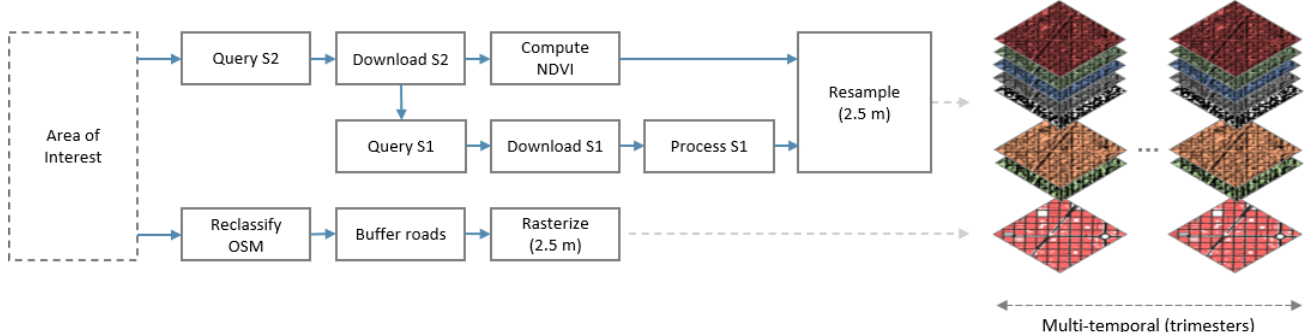
Figure 5. Dataset generation pipeline for a generic area of